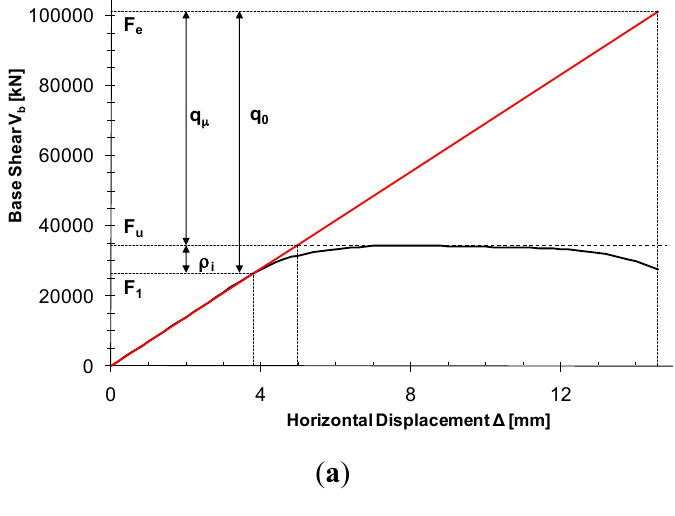
strength: ( a ) direction +X; ( b ) direction